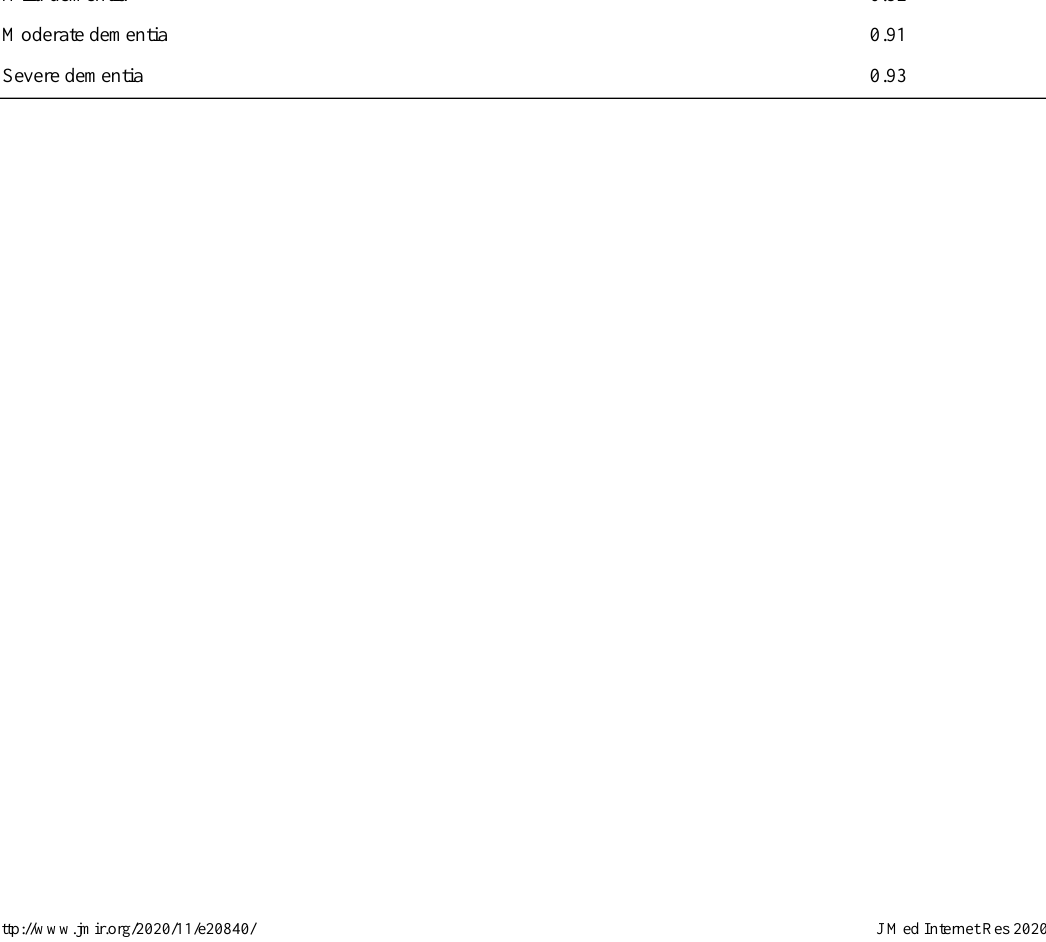
Cohen κ , mean (SD)Recall (weighted),